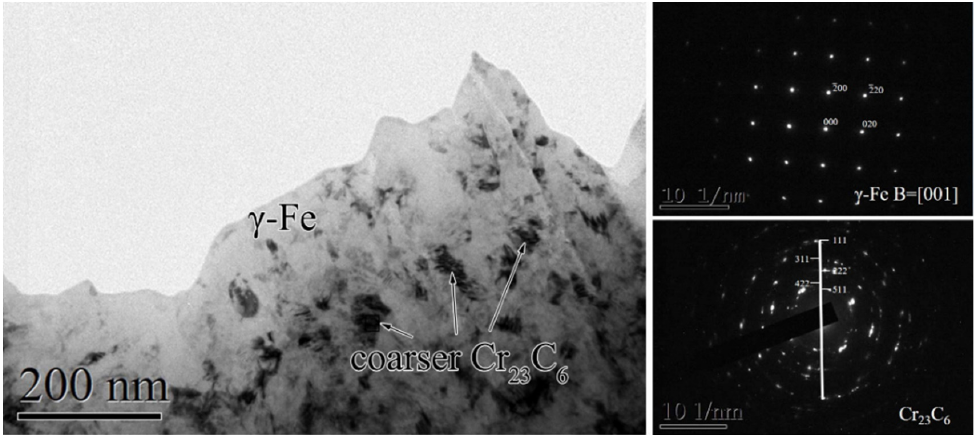
Figure 10. TEM microstructure of the 2#HR3C alloy and its SAED patterns for γ -Fe and coarser Cr 23 C 6 phases after exposure to pure water vapor at 650 °C for 1000 h.